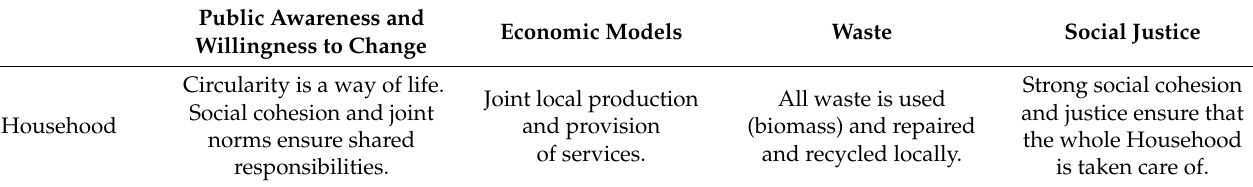
Table 2. The means by which households will deal with the current barriers to transition. Public Awareness and Economic Models Waste Social Justice Willingness to Change Circularity is a way of life. Strong social cohesion Joint local production All waste is used Social cohesion and joint and justice ensure that Househood and provision (biomass) and repaired norms ensure shared the whole Househood of services. and recycled locally. responsibilities. is taken care